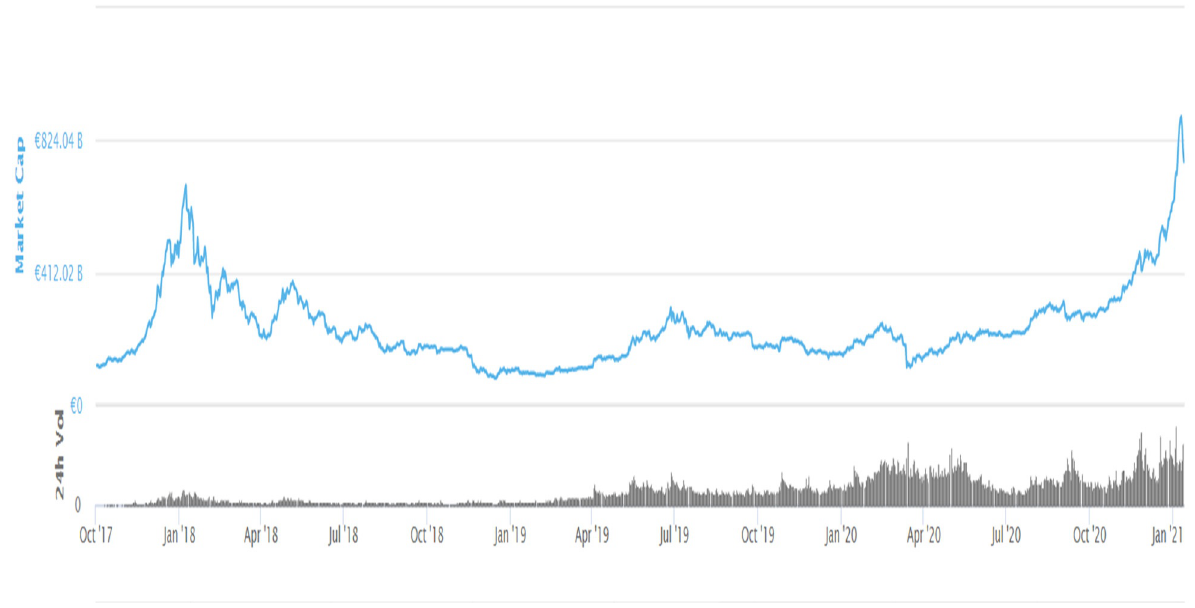
Figure 3. The development of total market capitalization.